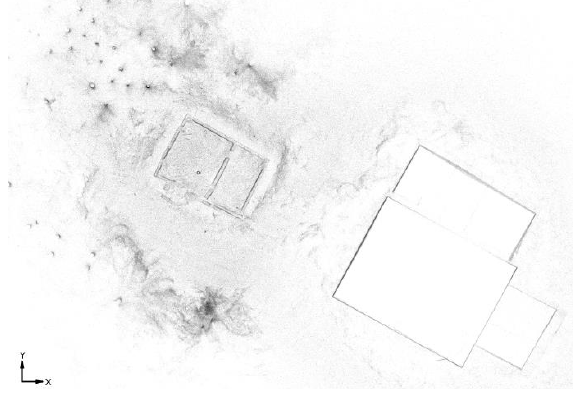
Figure 18 Using the “Draw” module in the GeoSlam HUB software an orthographic view on the captured data can be done On figure 18. and 19 remaining remnants of concrete foundations of a buried mining pit have very good visibility. At right there is the dilapidated structure of the engine room of the mining tower (Fig.16-19).